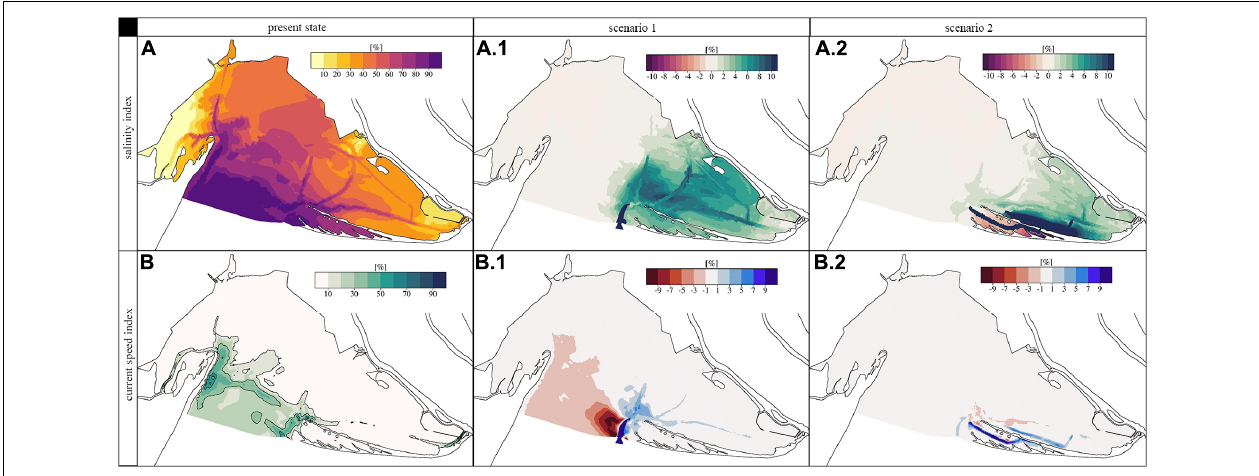
FIGURE 12 | Fitness indices of optimal growing conditions of the present state for salinity (FT2) and current speed (FT1). (A) FT2 present day; (A.1) difference between FT2 in the present day and Sc1 conditions; (A.2) difference between FT2 in the present day and Sc2 conditions. (B) FT1 present day; (B.1) difference between FT1 in the present day and Sc1 conditions; (B.2) difference between FT1 in the present day and Sc2